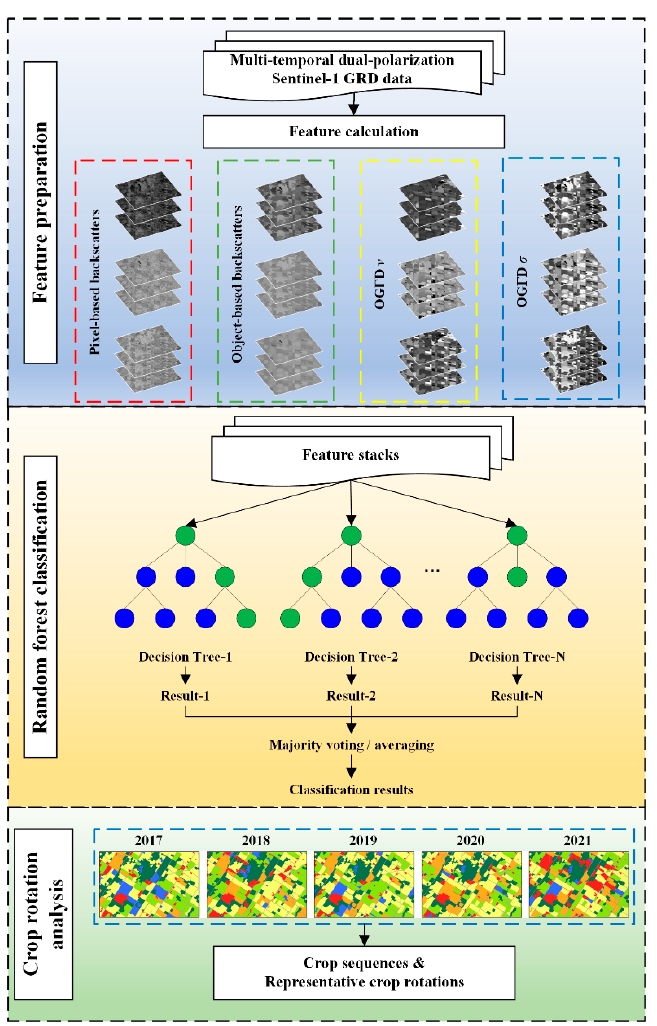
Figure 4. The workflow of the crop classification and representative crop rotation identification us- ing statistical features of time-series Sentinel-1 GRD data. statistical features of time-series Sentinel-1 GRD